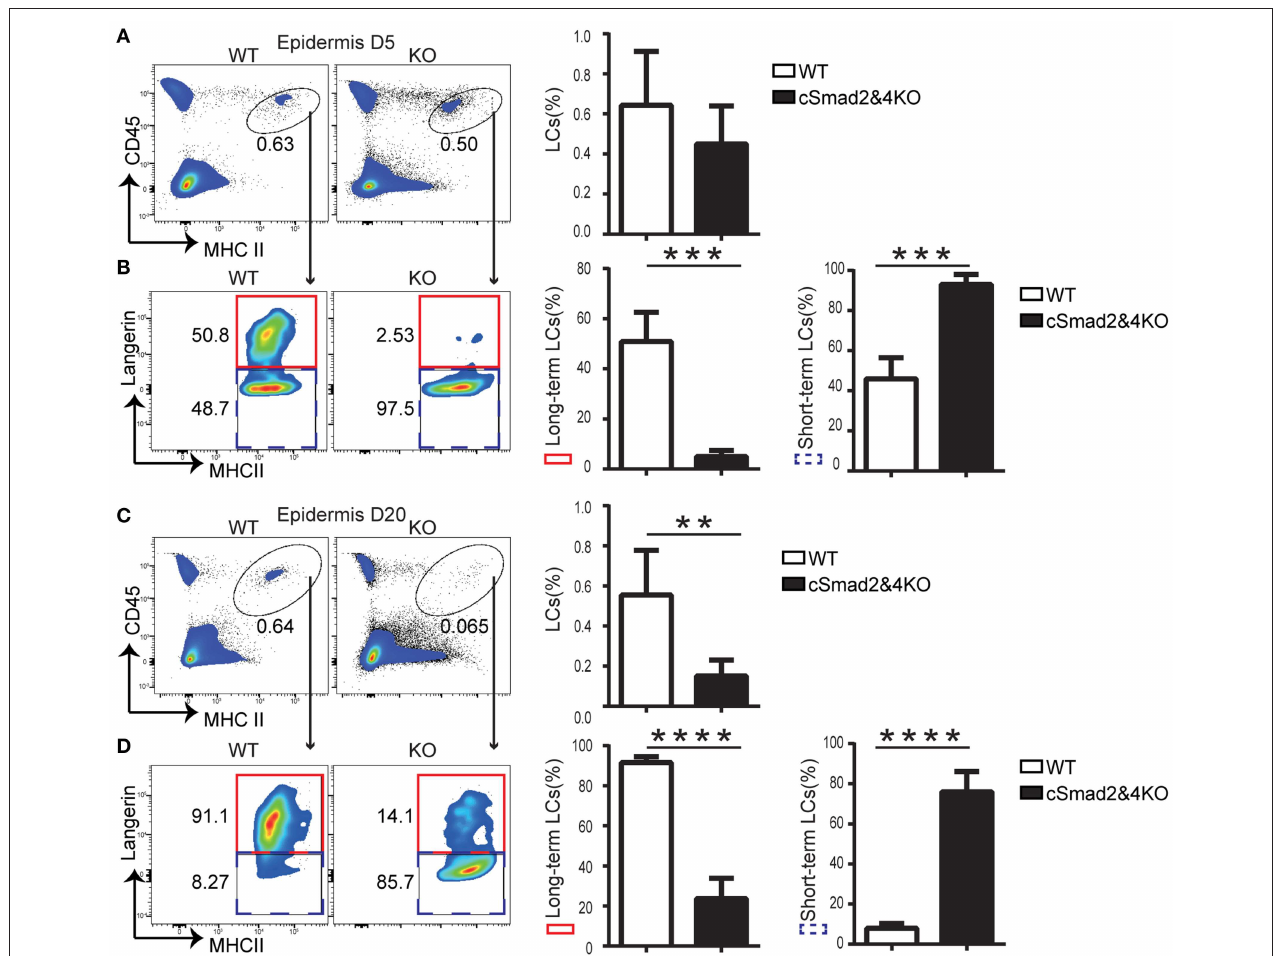
FIGURE 4 | Smad2/4 signaling is required for “long-term” LC repopulation. (A,B) Smad2/4 signaling pathway is not required for “short-term” LC repopulation. (A) The frequency of LCs at day 5 (D5) after UV treatment ( n = 9, P = 0.31); (B) The frequency of peripheral monocytes-derived “short-term” LCs (blue dashed line) and bone marrow-derived “long-term” LCs (red solid line) on pre-gated live LCs ( n = 9, *** P < 0.0002). (C,D) Smad2/4 signaling pathway is required for “long-term” LC repopulation. (C) The frequency of LCs at day 20 (D20) after UV treatment ( n = 12, ** P = 0.0019); (D) The frequency of peripheral monocytes-derived “short-term” LCs (blue dashed line) and bone marrow-derived “long-term” LCs (red solid line) on pre-gated LCs ( n = 12, **** P < 0.0001). Data were shown as mean ±